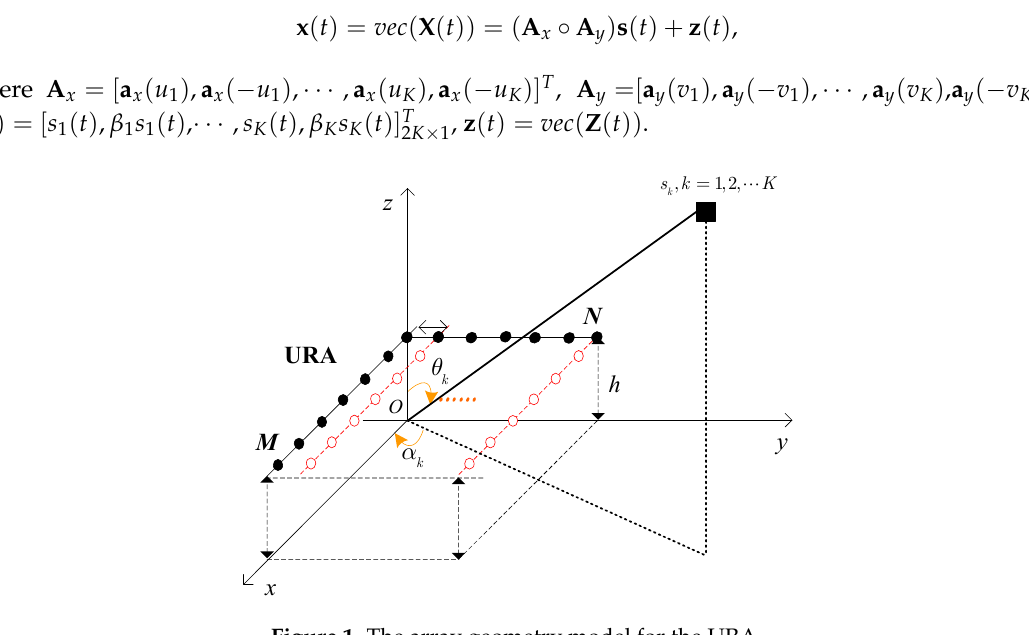
Figure 1. The array geometry model for the